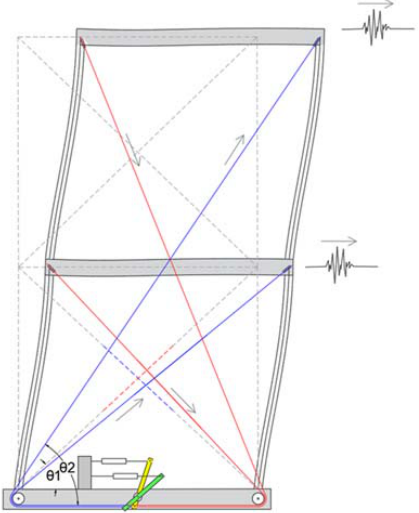
Figure 5. Conceptual model of a 2 ‐ story frame structure equipped with proposed system.